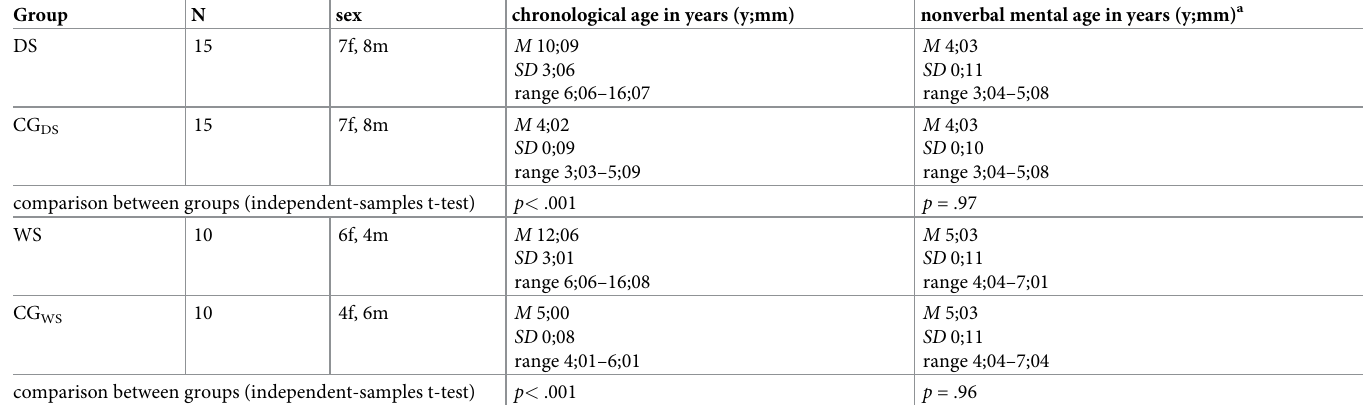
Table 1. Overview of